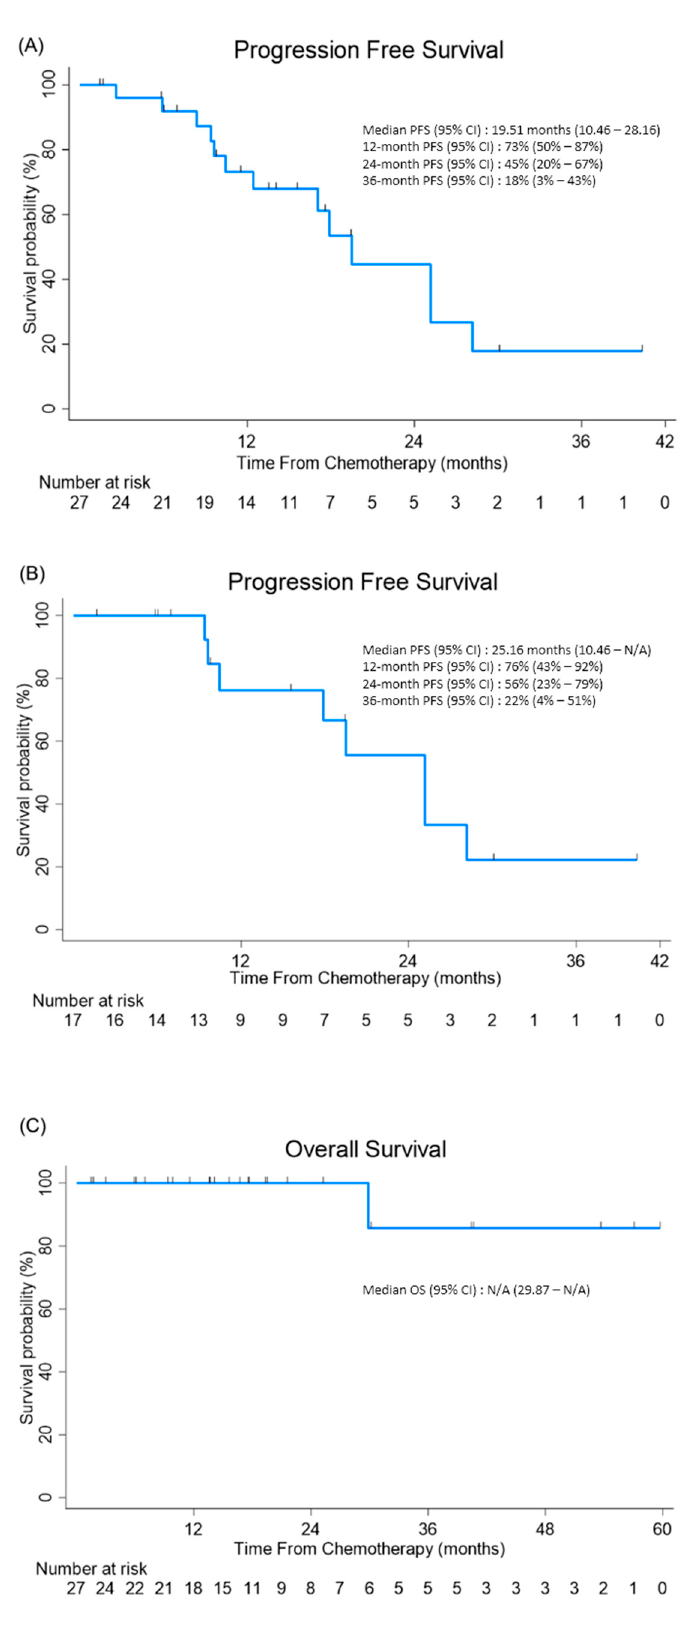
Figure 2 . A Kaplan–Meier curve for progression-free survival and overall survival: ( A ) A Kaplan– Meier curve of progression-free survival in all patients’ post-IP chemotherapy. ( B ) A Kaplan–Meier curve of progression-free survival in patients with primary ovarian cancer post-IP chemotherapy. ( C ) A Kaplan–Meier curve of overall survival in all patients’ post-IP chemotherapy.